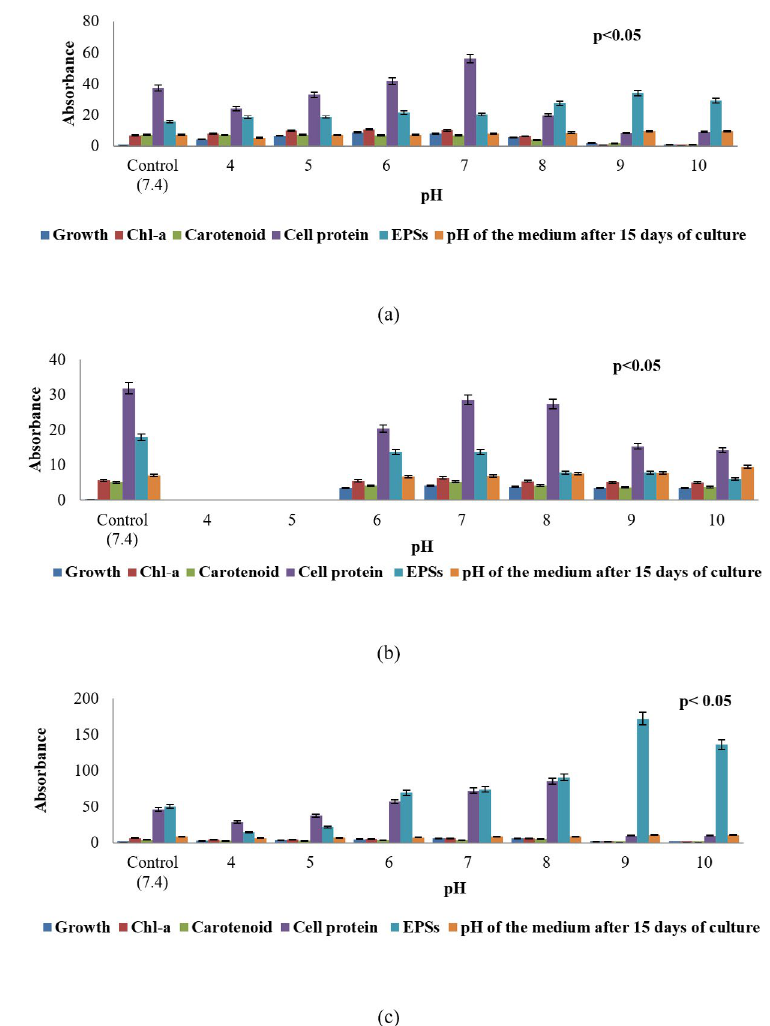
Fig. 1. Growth response, chlorophyll – a , carotenoid, soluble cell-protein, and extracellular polysaccharides content of three sub-aerial cyanobacteria, (a) Scytonema coactile (limestone,Gupteswar cave), (b) Scytonema geitleri (lime-washed wall, Building) and (c) Lyngbya aerugineo-coerulea (Stone carving,BhaskareswarTemple) submitted to different conditions of pH and changes in pH medium after 15 days of incubation of